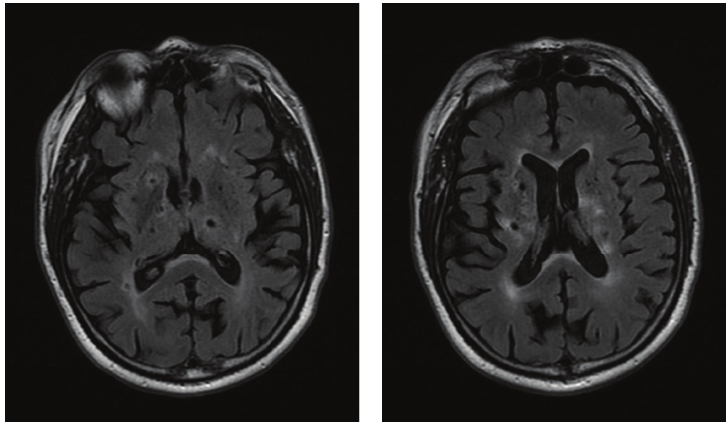
Figure 3: Fluid Attenuated Inversion Recovery (FLAIR) MRI of the brain showing extensive SVCD evident by multiple, bihemispheric subcortical